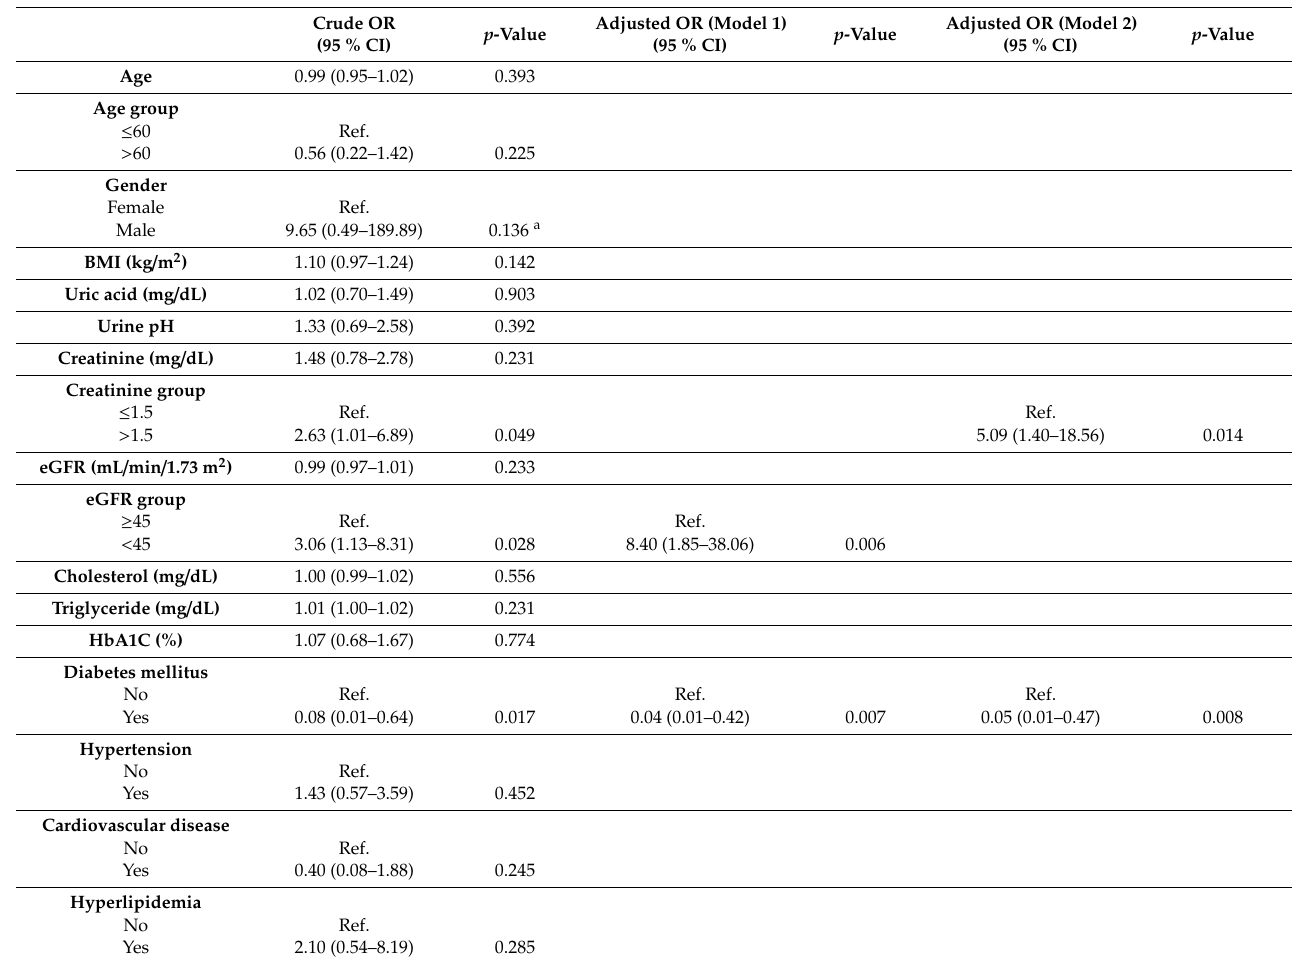
Table 2. Logistic regression analysis of risk factors for gout among uric acid urolithiasis